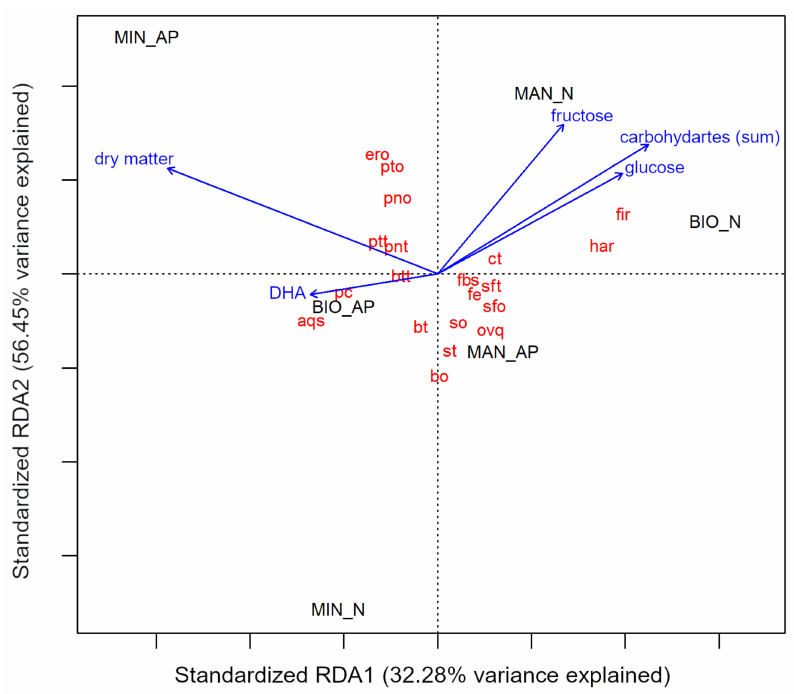
Figure 6. The redundancy analysis (RDA) biplot of chemical composition parameters (sugars, bioactive compounds) and sensory attributes of courgette fruits of Astra Polka (AP) and Nimba (N) cultivars grown in horticultural system with commercial organic fertilizer (BIO), manure (MAN), and mineral (MIN) fertilizer. Bo, buttery odor; pto, potato odor; so, sweet odor; sfo, sunflower odor; pno, pungent odor; ero, earthy odor; ptt, potato taste; sft, sunflower taste; bt, buttery taste; st, sweet taste; ct, cucumber taste; btt, bitter taste; pnt, pungent taste; pc, peel color; fc, flesh color; har, hardness;